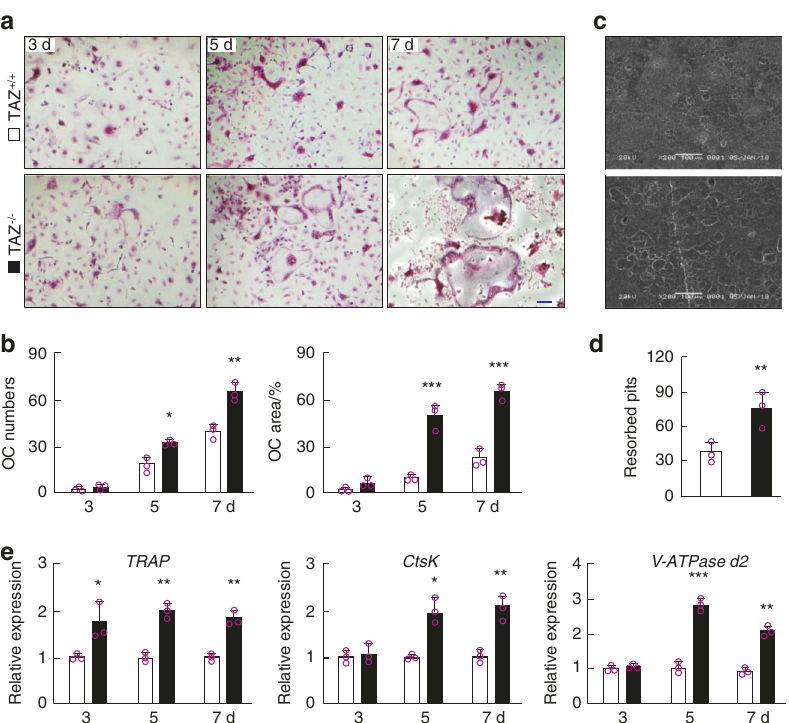
Fig. 4 TAZ gene knockout enhances osteoclast differentiation and bone resorption. a TRAP-stained multinucleated osteoclasts derived from TAZ + / + and TAZ − / − BMMs stimulated with 100 ng·mL − 1 RANKL for 3, 5, and 7 d. Scale bar 10 μ m. b Quantitative measurement of the number of TRAP-positive multinucleated osteoclasts with three or more nuclei and their average size (area) as a percentage of the total well area. c Scanning electron micrographs of bone resorption pits. Scale bar denotes 100 μ m. d Quantitative measurement of the number of resorption pits. e Real-time qPCR analysis of the expression of osteoclast marker genes. □ and ■ represent the TAZ + / + and TAZ − / − groups, respectively. One-way ( d ) or two-way ( b and e ) ANOVA followed by a post hoc Tukey test was performed. * P < 0.05, ** P < 0.01, and *** P < osteoclast formation but had no effect on bone resorption demonstrated signi fi cantly reduced tibial stiffness in TAZ f/f RANK Cre activity. The increased number of resorption pits maybe not due mice, but no difference was found in the maximum load bearing to increased bone resorption activity but rather due to elevated parameter (Fig. 3j and Supplementary Fig. 4f). Together, these osteoclast numbers. Real-time PCR analysis of osteoclast marker results indicated that the speci fi c deletion of TAZ in osteoclasts gene expression revealed upregulation of TRAP expression at all results in a low-bone mass phenotype reminiscent of osteoporosis time points (days 3, 5 and 7) and upregulation of CtsK and due to elevated numbers and activation of osteoclasts. V-ATPase d2 in the later stages of osteoclast differentiation (i.e., days 5 and 7), during which precursor cells were undergoing TAZ suppressed RANKL-induced osteoclastogenesis in vitro cellular fusion, in the TAZ − / − group when compared with the To further understand the cellular effects of TAZ on osteoclast TAZ + / + group (Fig. 4e). These effects of the loss of TAZ on differentiation and bone resorption, in vitro cellular and biochem- ical analyses were carried out. We fi rst examined the differentia- osteoclast formation, gene expression and bone resorption were tion potential of osteoclast precursor cells isolated from TAZ + / + recapitulated when using BMMs derived from TAZ f/f RANK Cre mice (Supplementary Fig. 6). and TAZ − / − mice. BMMs were stimulated with RANKL for 7 d, and To further con fi rm the cellular effects of TAZ on RANKL-induced their differentiation into mature osteoclasts was assessed by TRAP osteoclast formation and activity, BMMs derived from WT mice staining. As shown in Fig. 4a, b, TAZ − / − BMMs formed more TRAP- were transduced with lentiviral particles that led to overexpression positive multinucleated osteoclasts at days 5 and 7 than BMMs or silencing of the TAZ gene. TAZ overexpression suppressed derived from TAZ + / + littermates, suggesting higher precursor cell RANKL-induced osteoclastogenesis (Supplementary Fig. 7a) and fusion and/or cell spreading capacity. downregulated osteoclast marker gene expression (Supplemen- We thus examined whether TAZ − / − osteoclasts exhibited tary Fig. 7b). Consistent with the inhibitory effect on osteoclast alterations in bone resorption capacity. When the same numbers formation, bone resorption was similarly reduced following the of BMMs were seeded in bone disks, as shown in SEM overexpression of TAZ (Supplementary Fig. 7c). TAZ gene knock- micrographs and the subsequent quantitative analysis, TAZ − / − down (silencing ef fi ciency in Supplementary Fig. 8a, b) by BMMs showed elevated bone resorptive function, leaving behind silencing resulted in effects similar to those observed with KO more resorption pits and trails on the bone disks than TAZ + / + BMMs, demonstrating enhanced RANKL-induced osteoclast for- BMMs (Fig. 4c, d). To further exclude the effect of osteoclast mation and osteoclast marker gene expression (Supplementary formation on bone resorption, we activated both TAZ + / + and TAZ − / − BMMs with RANKL until osteoclast formation, and then Fig. 8c – e). The results from the overexpression and silencing experiments provided further evidence that TAZ inhibits RANKL- equal numbers of mature TAZ + / + and TAZ − / − osteoclasts were induced osteoclast differentiation. Collectively, these results con fi rmed that TAZ plays a physiological inhibitory role against RANKL-induced osteoclast formation. types of osteoclasts, which indicated that the loss of TAZ affected